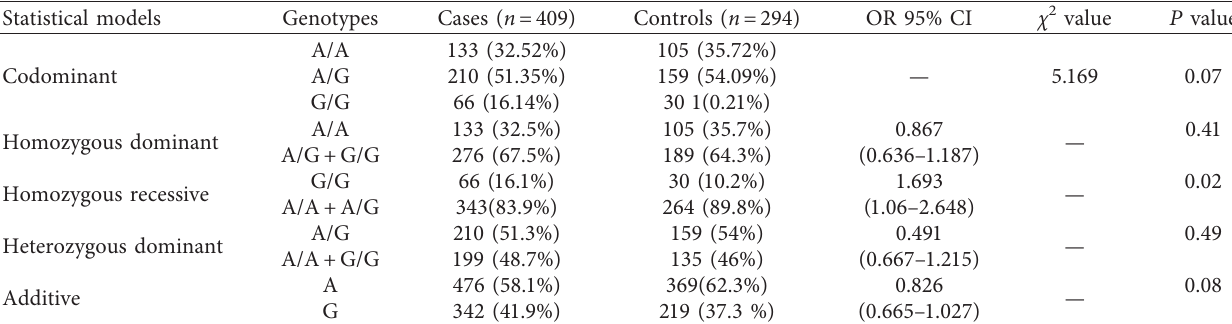
Table 2: Statistical analysis of the AFF 3 polymorphism (rs340630) in RA cases and